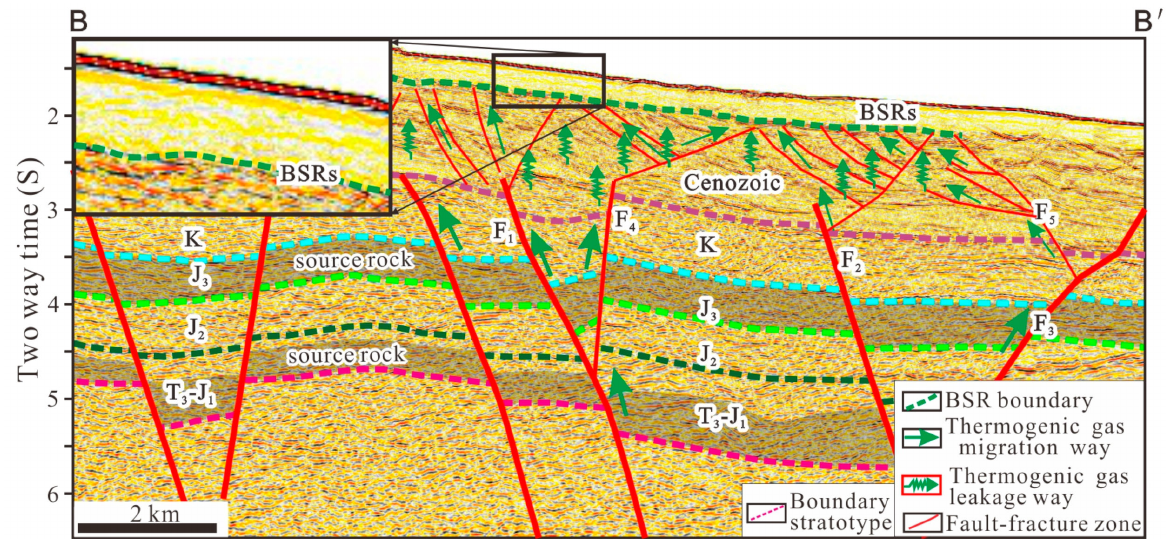
Figure 12. Hydrate accumulation pattern of section